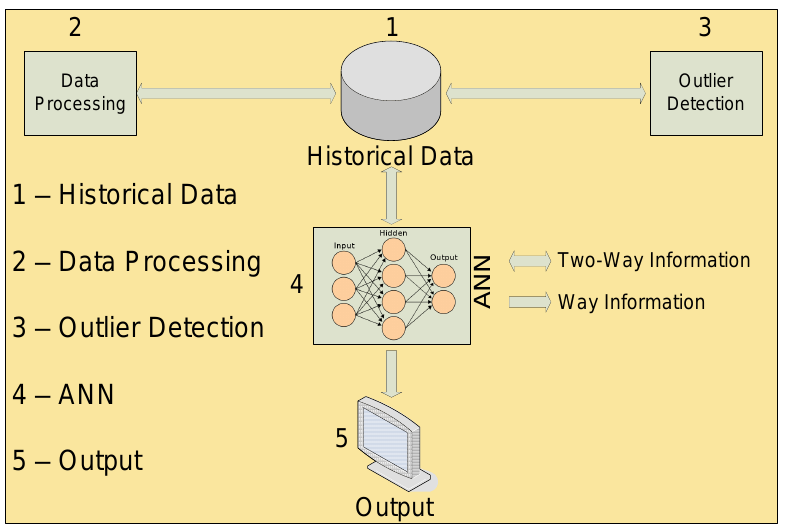
Figure 3. System architecture.